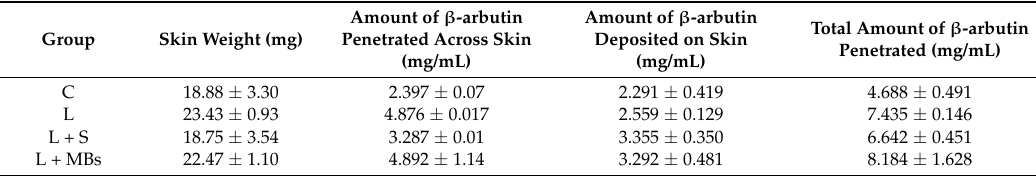
Figure 8. In vitro drug penetration in the different experimental groups (see Table 2) through pigskin in a Franz diffusion cell at 36–37 ◦ C. Data are mean and SD values. Table 2. Permeated amount of β -arbutin after 24h, deposited on the skin, and penetrated across the skin. Data are mean ± SD values. C, penetrating β -arbutin alone; L, laser combined with penetrating β -arbutin; L + S, laser combined with saline and penetrating β -arbutin; L + MBs, laser combined with MBs and penetrating β